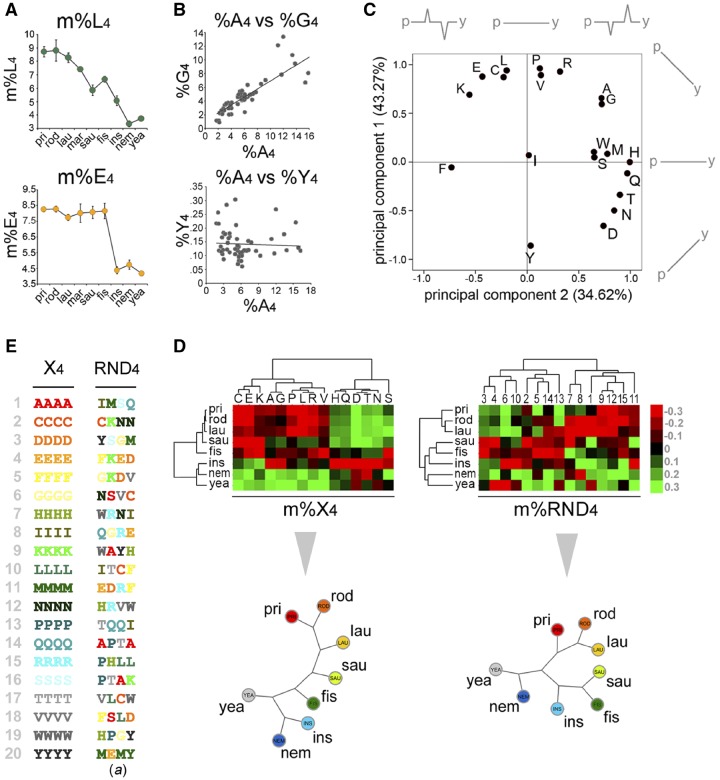
—Interrelated evolutionary dynamics of AARs carry phylogenetic signal. (A) Graphs showing the mean %X4s (i.e., m%X4s) in the indicated taxa for the indicated AARs. The upper and lower graphs show the phylogenetic trends of m%L4 and m%E4, respectively. (B) Scatterplots showing the correlation between %A4 and %G4 (upper graph), but not between %A4 and %Y4, in the 55 proteomes that were analyzed. (C) Graph showing the results of a PCA of the phylogenetic occurrence profiles of the 20 AARs in eukaryotic taxa. PCA identifies two major components to the variation of AAR occurrence from yeast (y) to humans (h), as schematized near two axes, each accounting for the indicated percentage of the total variance (in brackets). (D) Upper row. Cluster analysis of the m%X4 (left) and of one set of the %RND4 parameters (right) in the indicated taxa. Lower row. Unrooted phylogenetic trees derived from the dendrograms in the upper row. The tree derived from m%X4 parameters (left) reproduces standard phylogeny. This is not the case for the tree derived from m%RND4 parameters (right). (E). Primary sequence of a set of random tetrapeptides (RND4) obtained by reshuffling of the 20 homopolymeric peptides (X4) shown on the left.